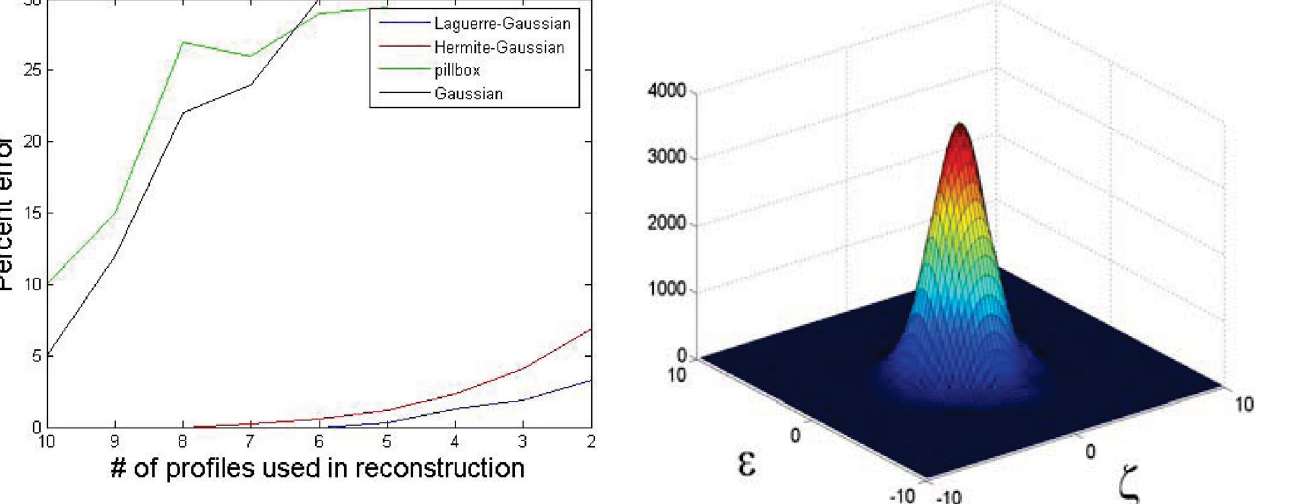
FIG. 6. (Color) Longitudinal phase-space reconstruction of E beam in equilibrium (turn 100, before lasing) using 2 profiles, 6.82 (cid:15) apart. Scale is in normalized units indicated in Eq.